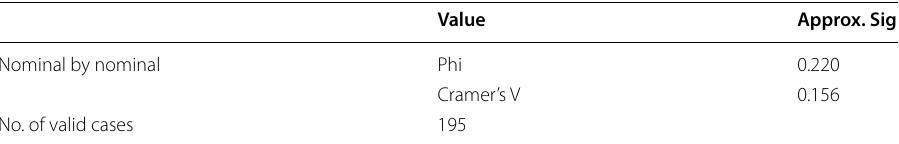
Source Field Survey Result,